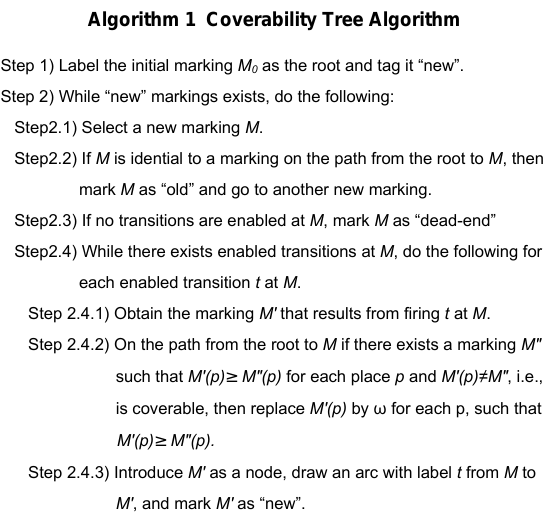
Algorithm 1 Coverability Tree